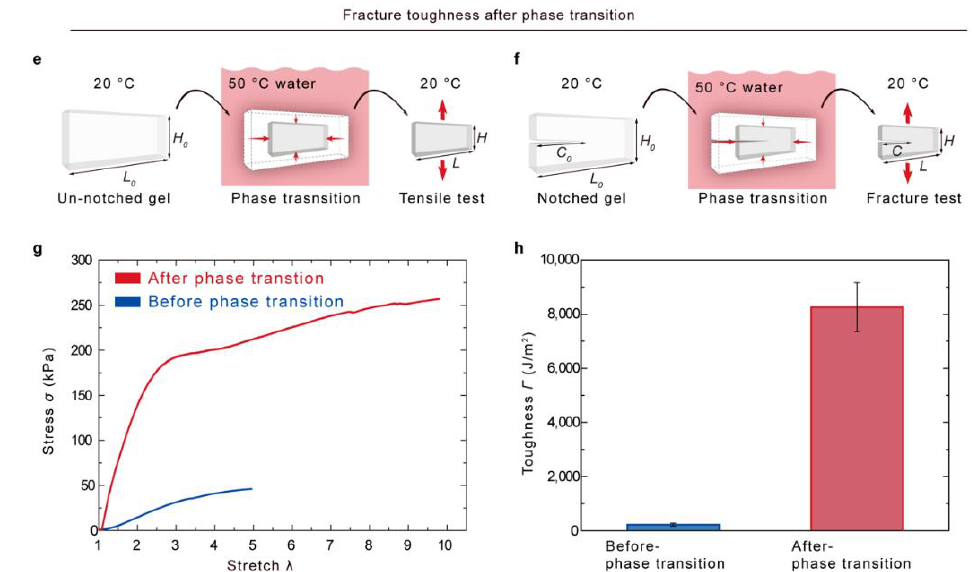
Figure 2. Fracture toughness of PNIPAAm–alginate hybrid gel. ( a ) Un-notched hybrid gel stretched to rupture for a tensile test. Hybrid gels with various weight ratios of PNIPAAm/(PNIPAAm + alginate) were tested. The sample design shown in the inset ( L / H 0 ≥ 20) was used for the tensile tests. The . λ = 2 min − 1 . ( b ) The elastic modulus was calculated from the stress– stretch rate was kept constant at stretch curves in ( a ) and plotted as a function of the weight ratio of PNIPAAm/(PNIPAAm + alginate). The elastic modulus was increased when the proportion of alginate increased. ( c ) Fracture tests were performed on the notched samples shown in the inset ( C 0 / L ≈ 0.5). Onset crack propagation was monitored by a camera during uniaxial stretching. Cracks tended to propagate earlier with increasing amounts of alginate. ( d ) The fracture toughness calculated using Equation (S1) was plotted as a function of the weight ratio of PNIPAAm/(PNIPAAm + alginate). The hybrid gel has a maximum toughness of approximately 700 J/m 2 at 88.89 wt. %. The weight of the covalent crosslinker, MBAA, was fixed at 0.00167; the weight of the ionic crosslinker, CaSO 4 , was fixed at 0.2327 (water content: 89.59 wt. %). ( e – h ), Fracture toughness was also measured after the phase transition. ( e , f ) Hybrid gels were fully swollen in 20 °C water for a day, then submerged into 50 °C water for a day. After the phase transition, un-notched and notched sample gels were subjected to tensile and fracture tests, respectively. ( g ) Un-notched hybrid gel after phase transition shows two times more stretchability and five times more strength than un-notched hybrid gel before the phase transition. As a result, ( h ) the fracture toughness of the hybrid gel after phase transition is 8258 J/m 2 , which is 38 times higher than that of the hybrid gel before phase transition. H = 5 mm ( C / L ≈ 0.5). Error bars show standard deviation; n ≥